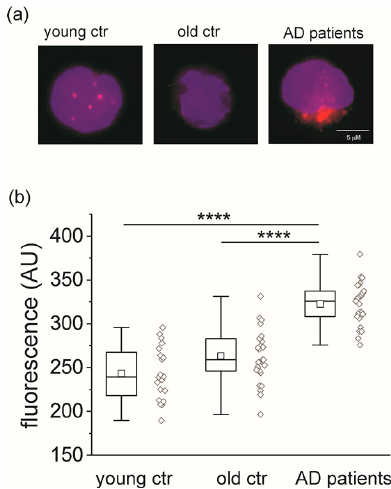
Figure 1. Chloride intracellular channel 1 (CLIC1) protein overexpression in circulating monocytes of Alzheimer’s disease (AD) patients. ( a ) Representative confocal images of CLIC1 protein staining (red) in monocytes (blue nuclei) isolated from peripheral blood samples of young (left) and elderly (center) individuals and AD patients (right); ( b ) the average of CLIC1 fluorescence measured in single monocytes is not significantly different between young ( n = 20) and old ( n = 27) individuals, while it is significantly higher in AD patients ( n = 25) (****, p < 0.0001, AD vs. young and AD vs. old, one-way ANOVA, Tukey’s multiple comparisons test).